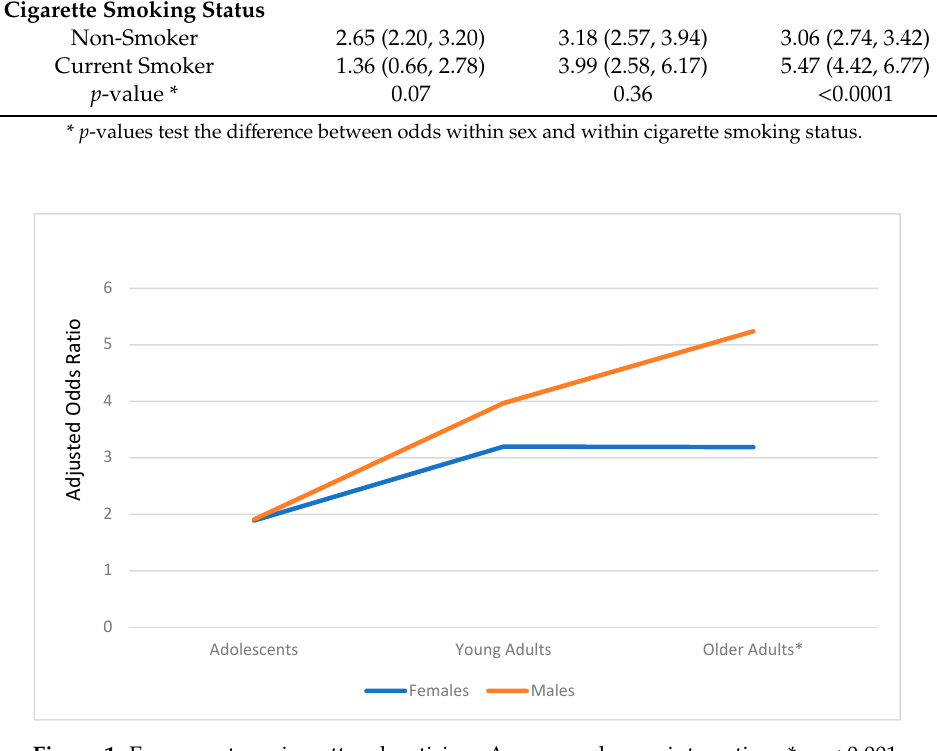
Figure 1. Exposure to e-cigarette advertising: Age group by sex interaction. *: p < 0.001.